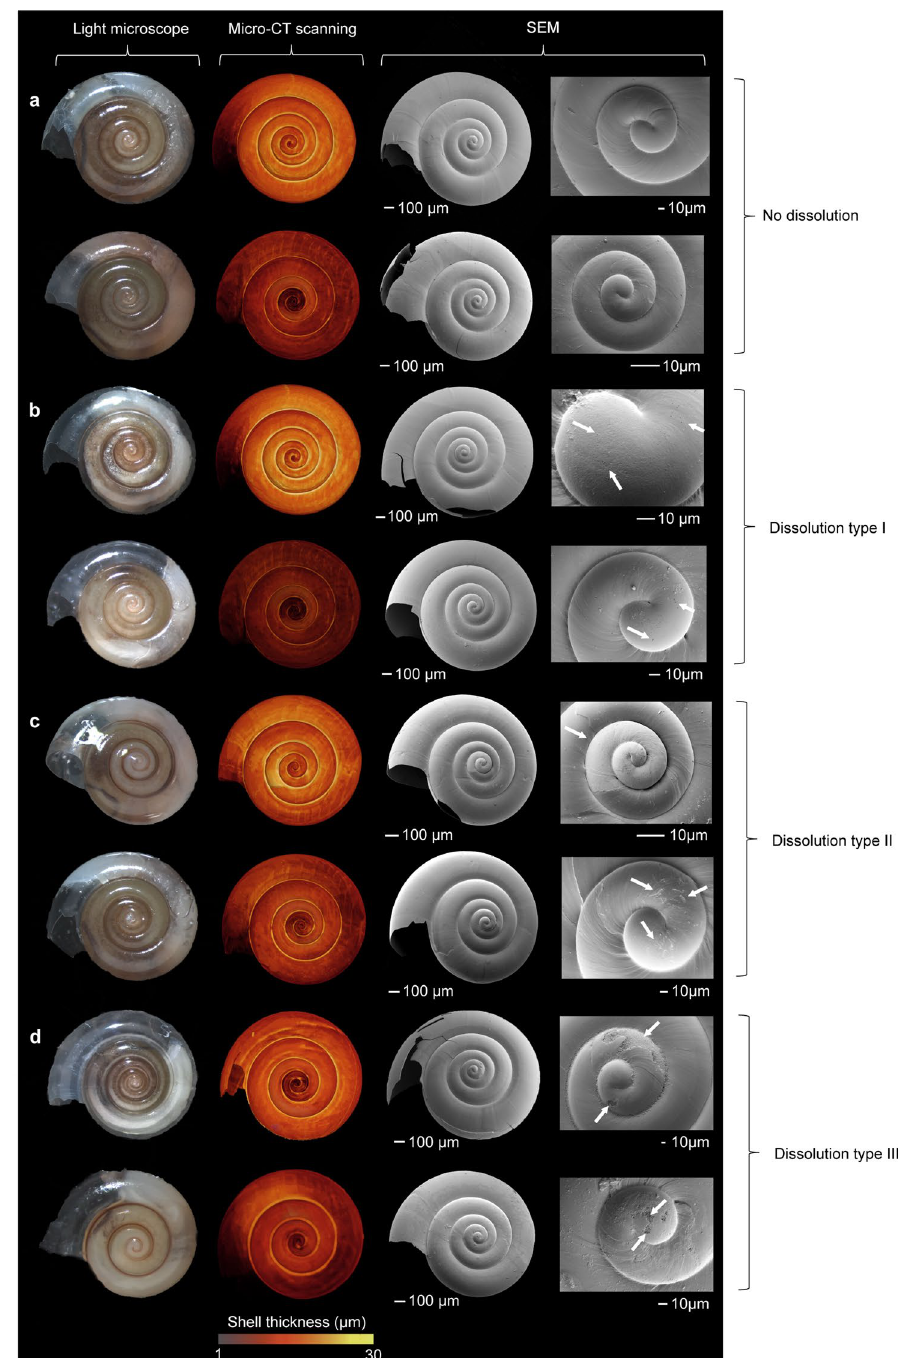
Figure 4. Shell images obtained by light microscopy, micro-CT and scanning electron microscopy (SEM) of eight Limacina helicina specimens illustrating the variability in our data set. ( a ) Specimens with a thick shell (upper row) and a thin shell (lower row) without dissolution marks. ( b ) Specimens with a thick shell and a thin shell showing marks of initial dissolution (Type I), with pitting at the inner whorl (indicated by arrows). ( c ) Specimens with a thick shell and a thin shell with Type II marks of dissolution penetrating the aragonite structure. ( d ) Specimens with a thick shell and a thin shell with Type III dissolution, characterized by deep damage on the outer shell surface. All images in the same row are of the same